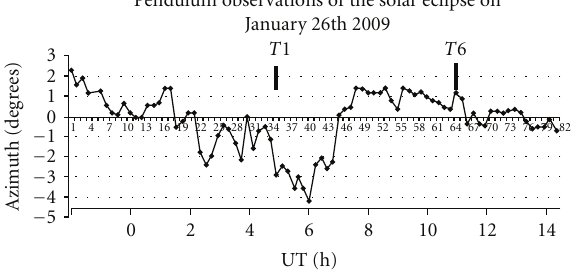
Figure 5: Changes in the pendulum oscillation plane on the date of the solar eclipse. Numbers on the linear scale in the center of the figure indicate the sequential number of measurements that were taken every 11 minutes.